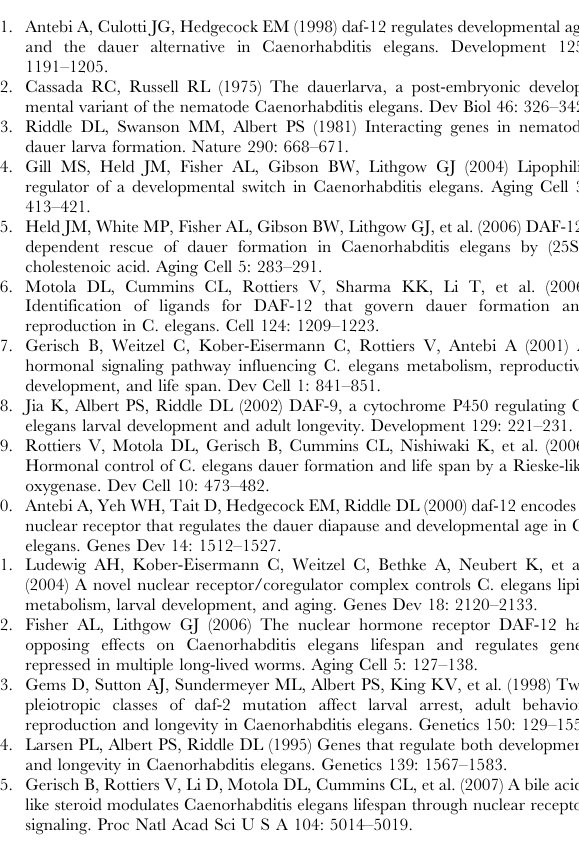
Figure S7 Table of DAF-12 target miRNAs. (PDF) Figure S8 Oligos used to subclone promoter regions for pGL3 Luc and pPD95.75 vectors. Restriction sites added for subcloning are indicated in red. (PDF) Table S1 Genes within 1 Kb, 2 Kb and 5 Kb of identified DAF-12 binding sites. (XLS) Table S2 Genes identified as DAF-12 binding sites when control ( daf-12(0) ) was positive. Table S3 Gene ontology analysis of DAF-12 targets with DAVID